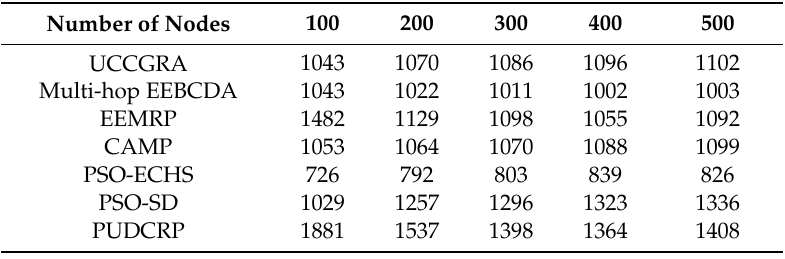
Table 5. LND of di ff erent algorithms in the 200 m × 200 m network area.